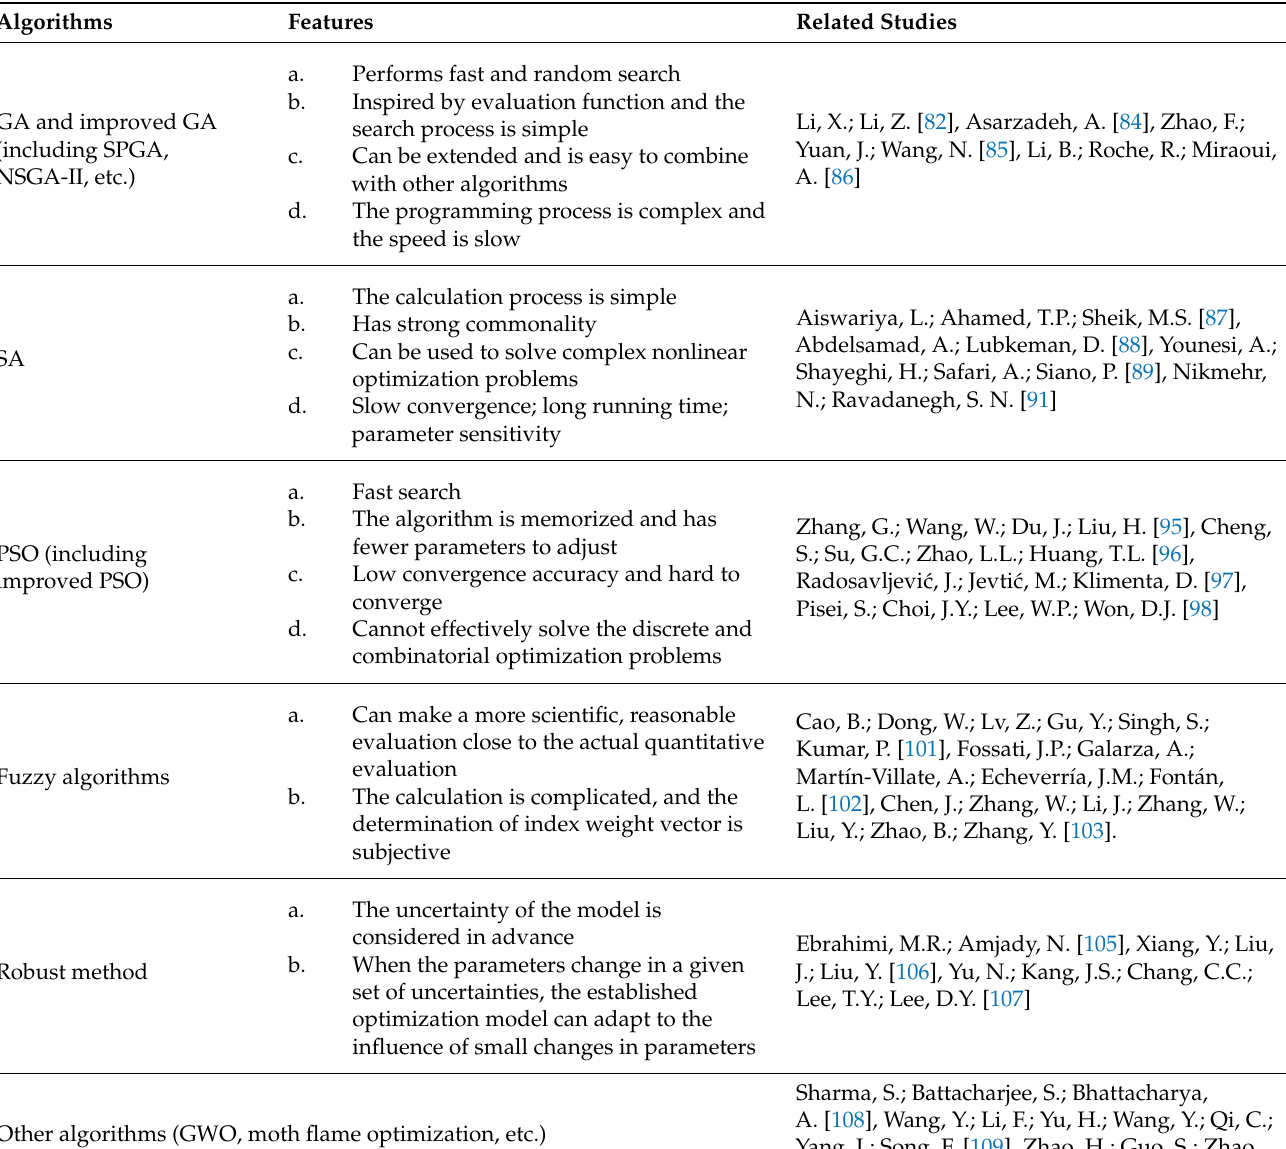
Table 2. The features and related studies of the most used